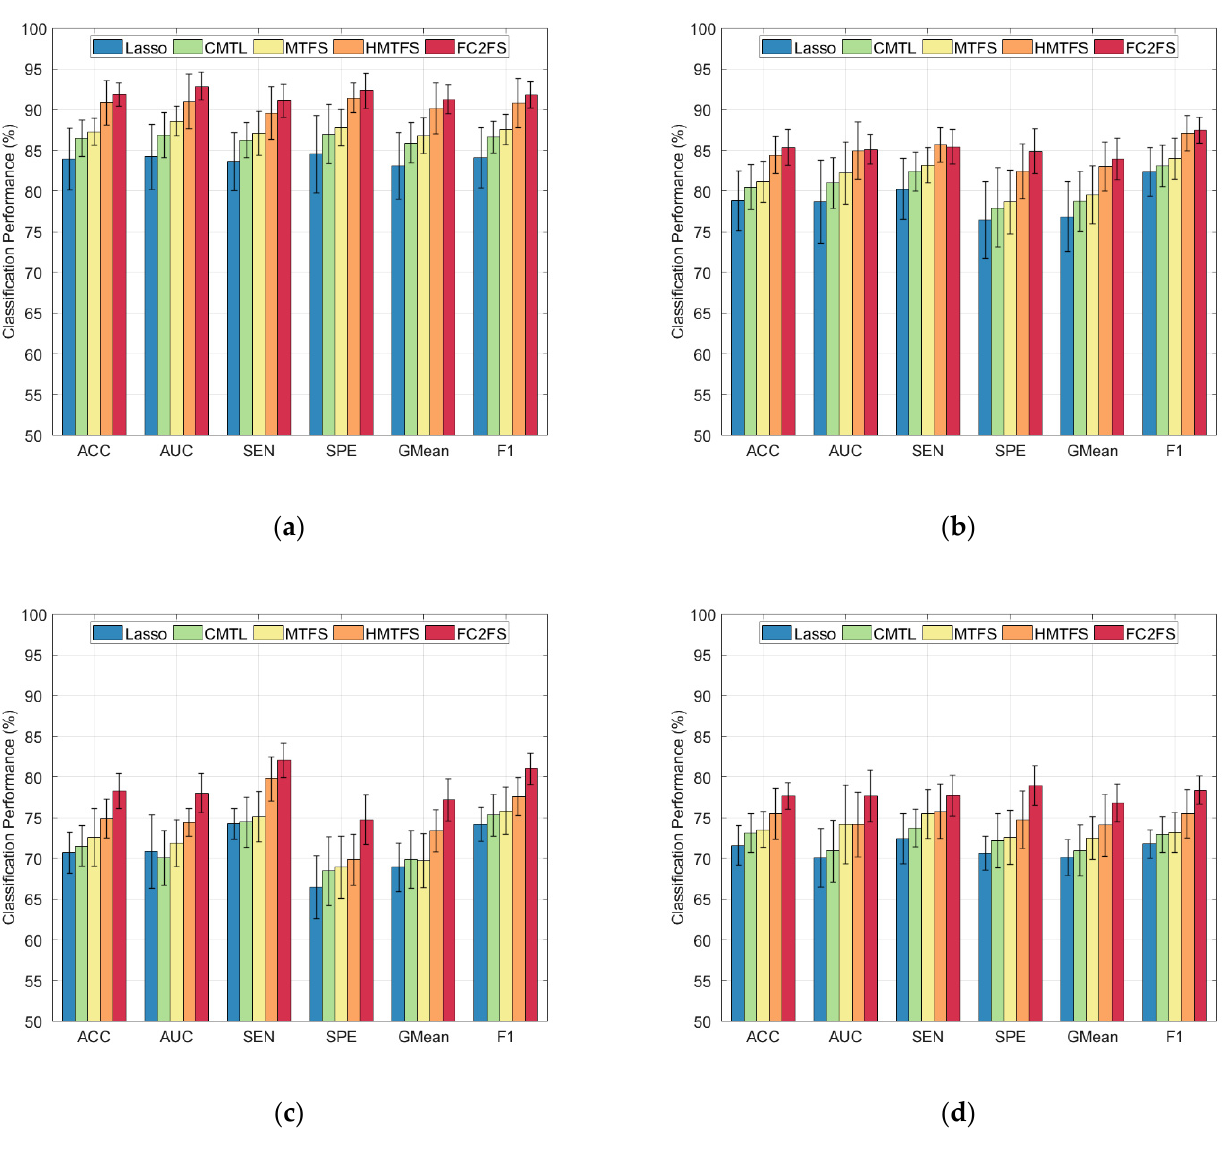
Figure 2. Classification performance of different methods. ( a ) NC vs. AD, ( b ) NC vs. LMCI, ( c ) NC vs. EMCI, ( d ) EMCI vs. LMCI.